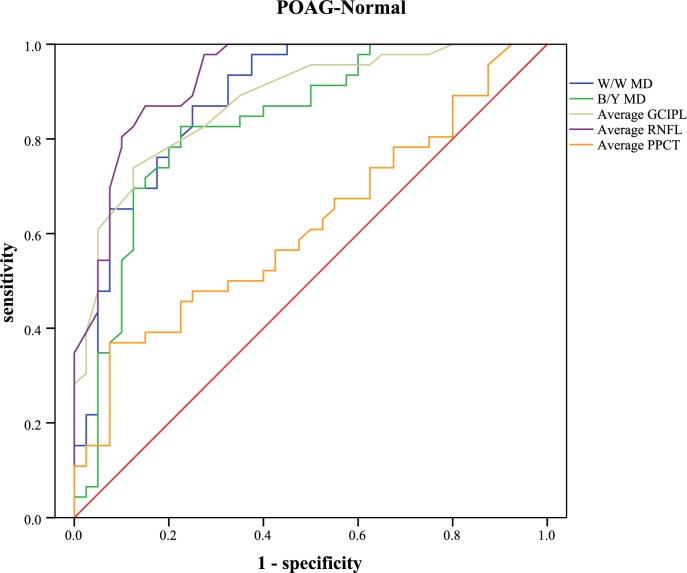
ROC curves for visual field indices and OCT parameters to discriminate POAG from normal eyes.